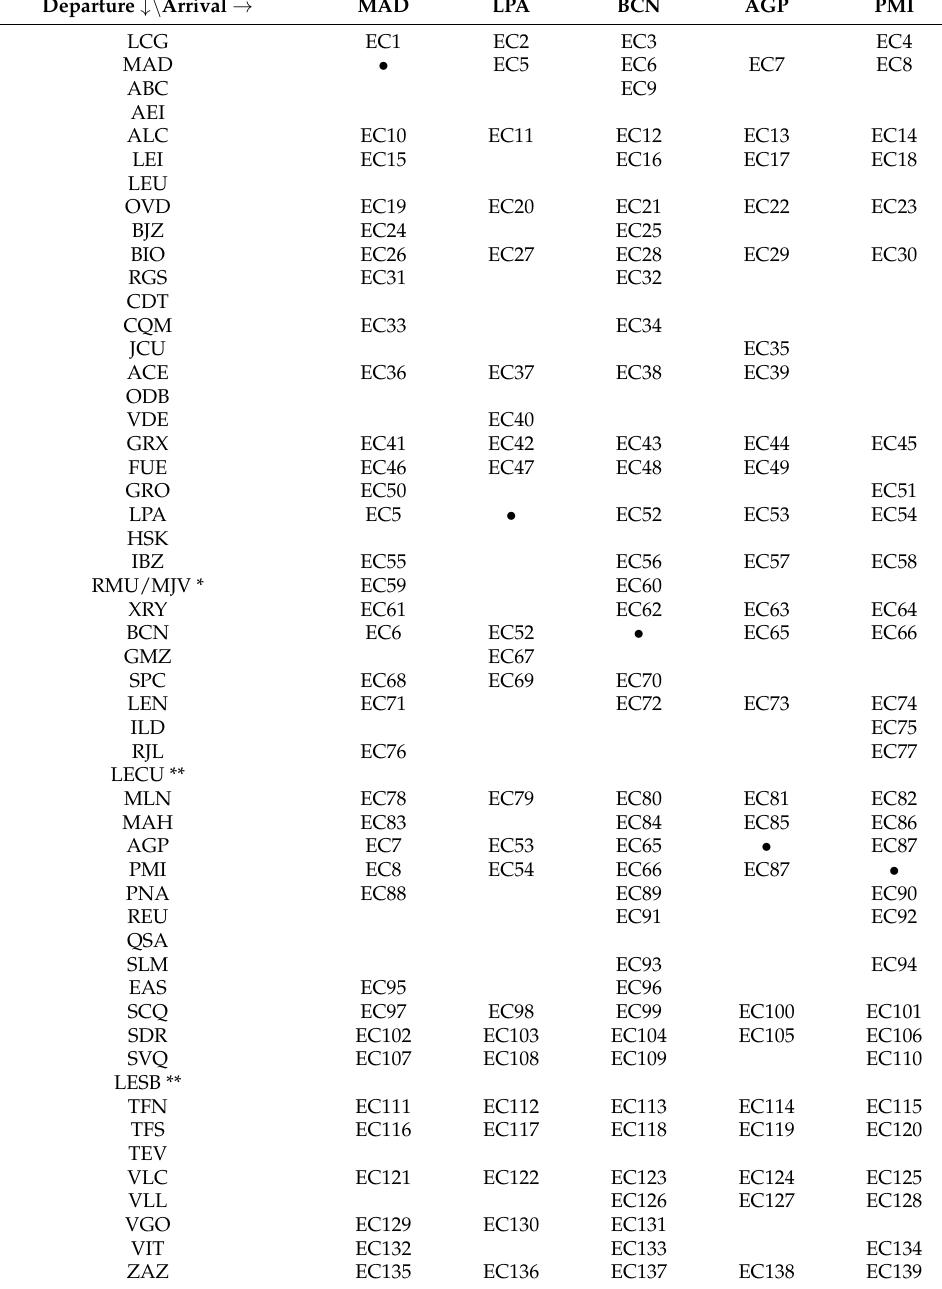
Table 3. Main domestic routes in the Spanish airport network over the study period